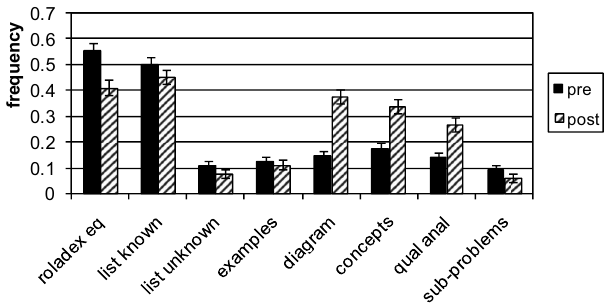
FIG. 1. Frequency distribution of how often a problem-solving method was mentioned in a student reflection. The reflections writ- ten at the start of the course (cid:1) “pre” (cid:2) are shown in solid black and the reflections written at the end of the course (cid:1) “post” (cid:2) are shown as a striped histogram. The “limiting” strategies are shown on the left and the “expansive” strategies are shown on the